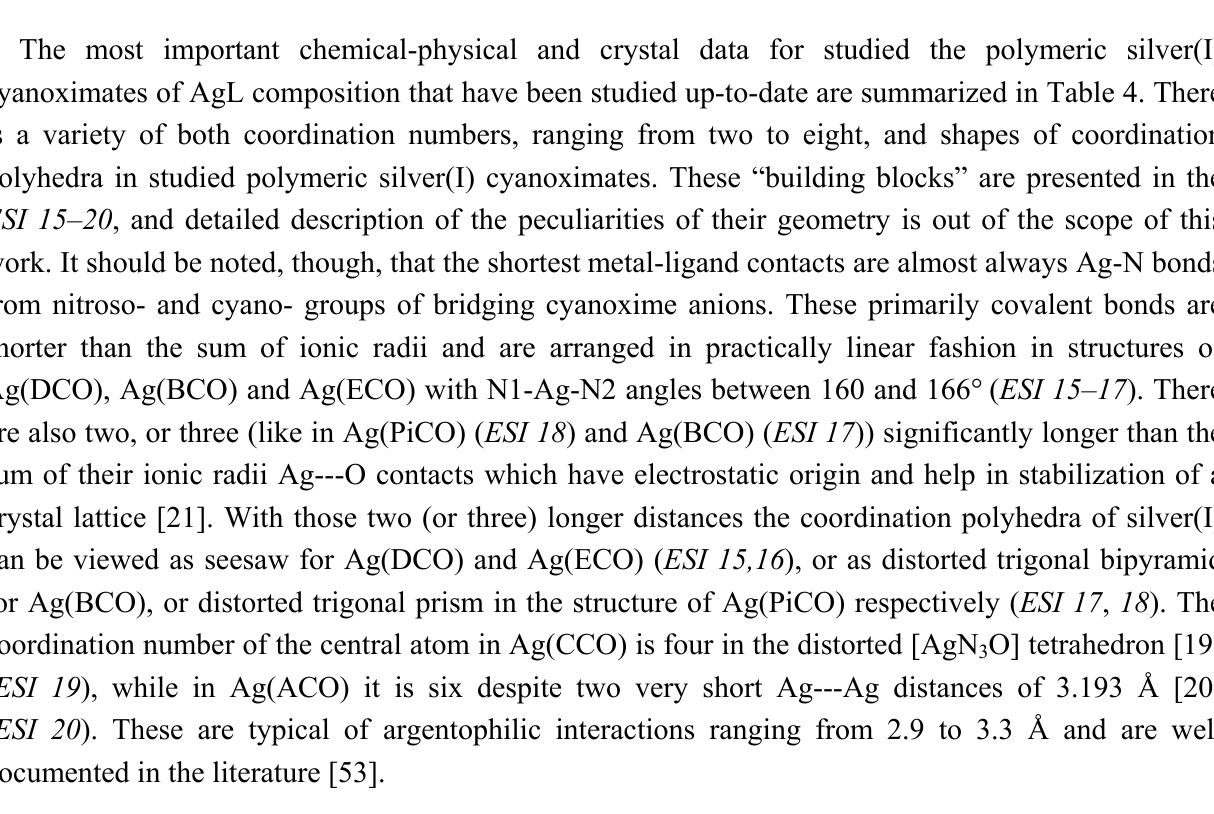
Figure 13. Fragments of 3D-polymeric structure of Ag(CCO): ( a ) unit cell content view along c ; ( b ) view along b direction. Coloring scheme here and in all following